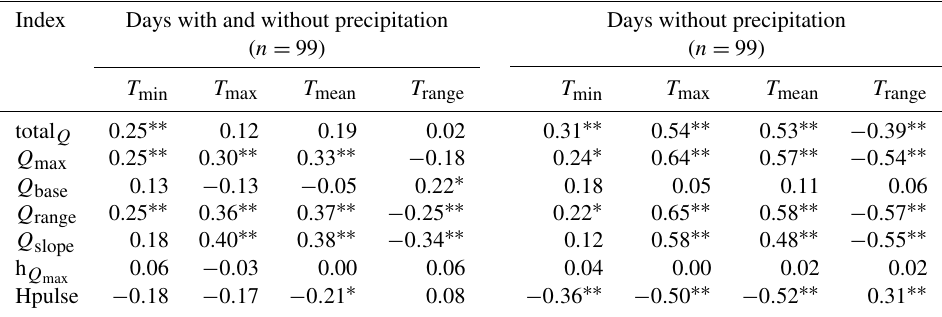
Figure 4. Principal component analysis on hourly streamflow: (a) scores of the three main principal components (patterns of daily stream- flow), with gray lines indicating the scores for each one of the 25 bootstrapped samples in the recursive PCA, and colored lines indicating the average. (b) Evolution of the number of days per month that show maximum correlation with each PC. Red corresponds to PC1, blue corresponds to PC2 and green corresponds to PC3. Table 2. Pearson correlation coefficient between daily hydrological indices and temperature for days with and without precipitation (left) and for days without precipitation (right) between July 2013 and June 2017. The correlation values correspond to the average obtained by 100 resampling iterations ( n = 99) of the correlation test. The symbols ∗ and ∗∗ indicate that correlations are significant at 95% and 99% confidence respectively (two-tailed